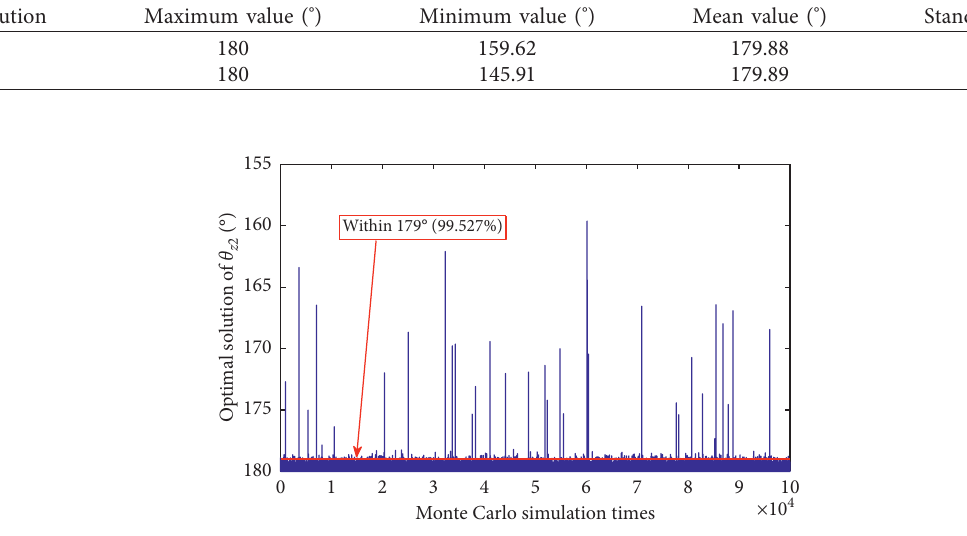
Figure 8: The distribution of the genetic optimization results for a rotor at the 2nd stage.